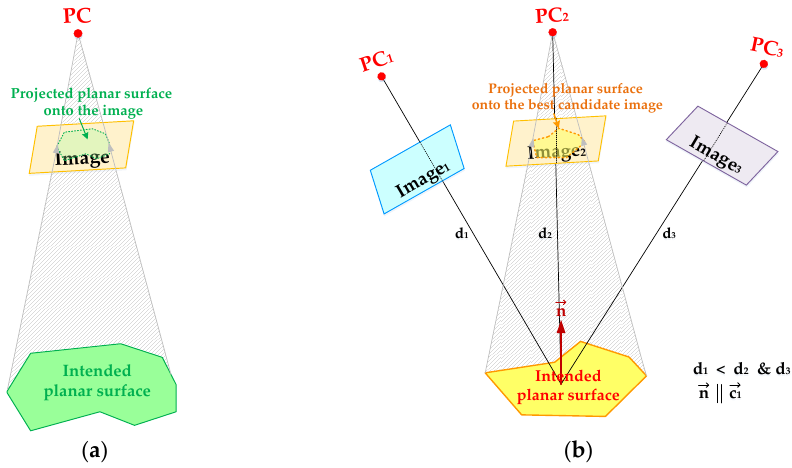
Figure 13. Rendering of a fully-visible planar surface within ( a ) a single appropriate image or ( b ) multiple appropriate images.